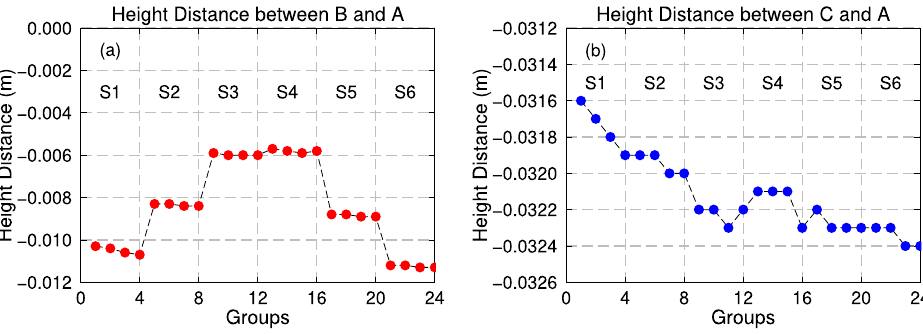
Figure 7. Height distance variations of B ( a ) and C ( b ) toward A provided by the static level.